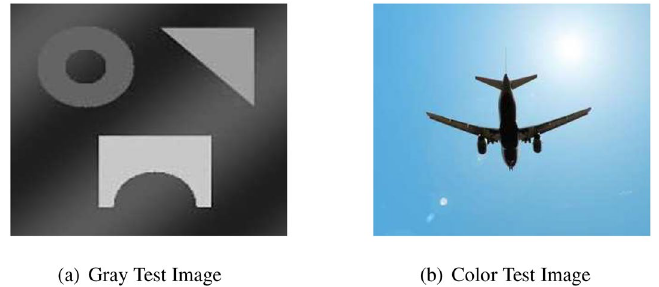
Figure 1. Two test images: the first one is gray-scale which is suffered from intensity inhomogeneity while the second one is color image having brightness in the background. These inhomogeneous images are taken from Cai et al. 14 and are publicly available at the kaggle website 33